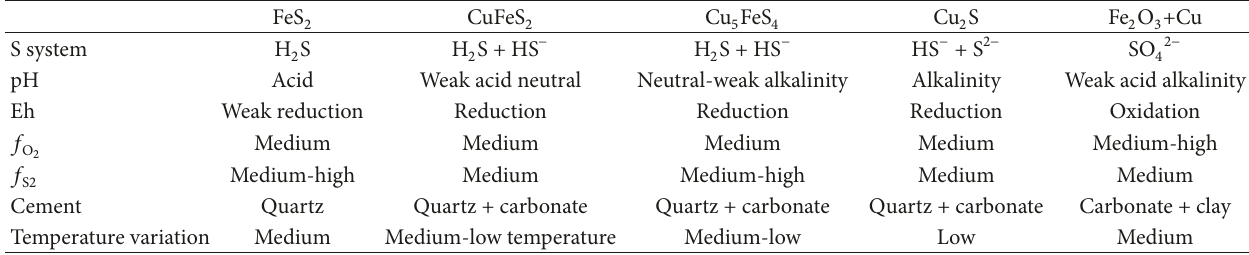
Table 7: The features of mineral